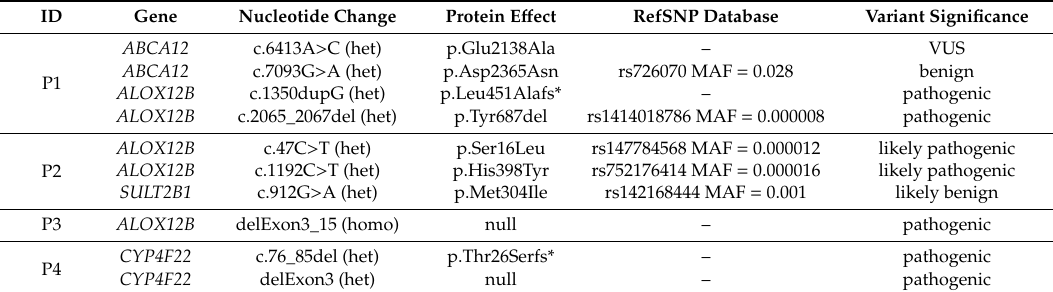
Table 2. List of autosomal recessive congenital ichthyoses (ARCI)-related genomic variants